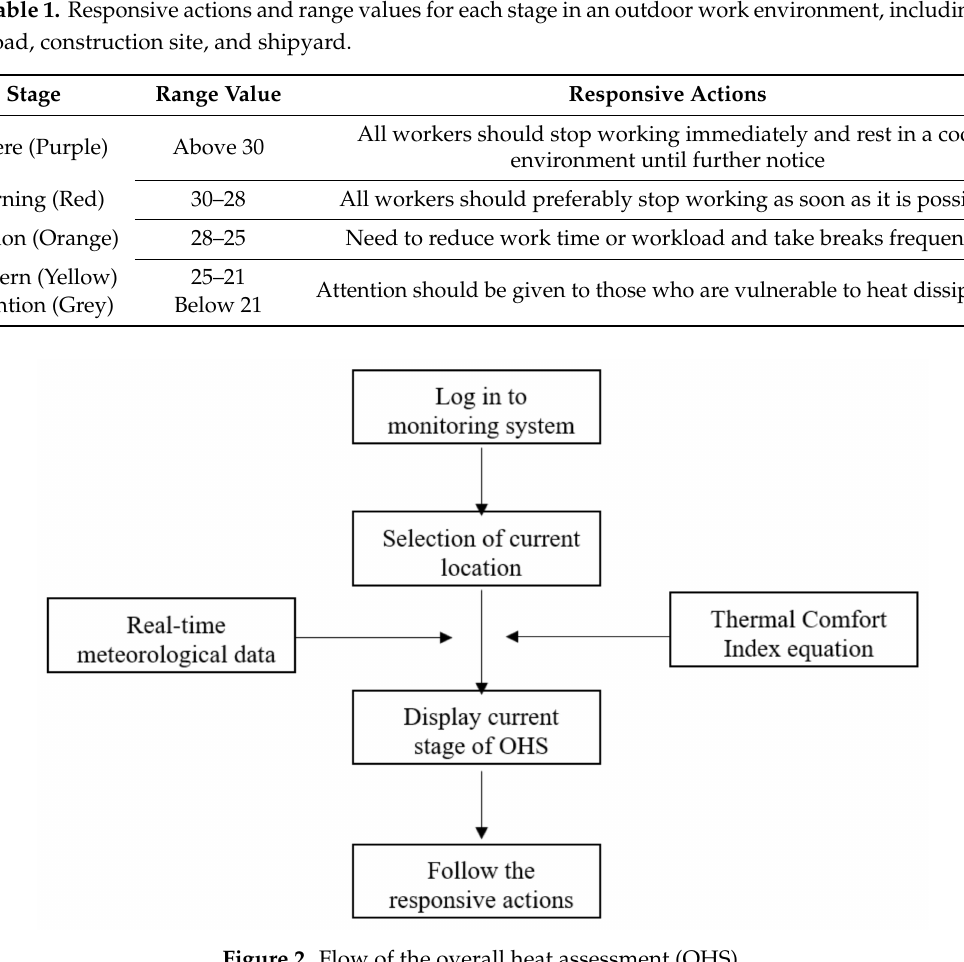
Figure 2. Flow of the overall heat assessment